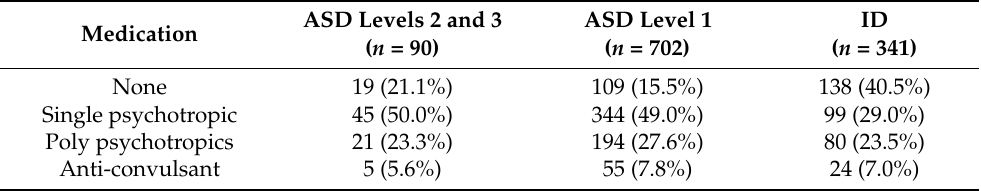
Table 2. The number and percentage of children receiving medication.